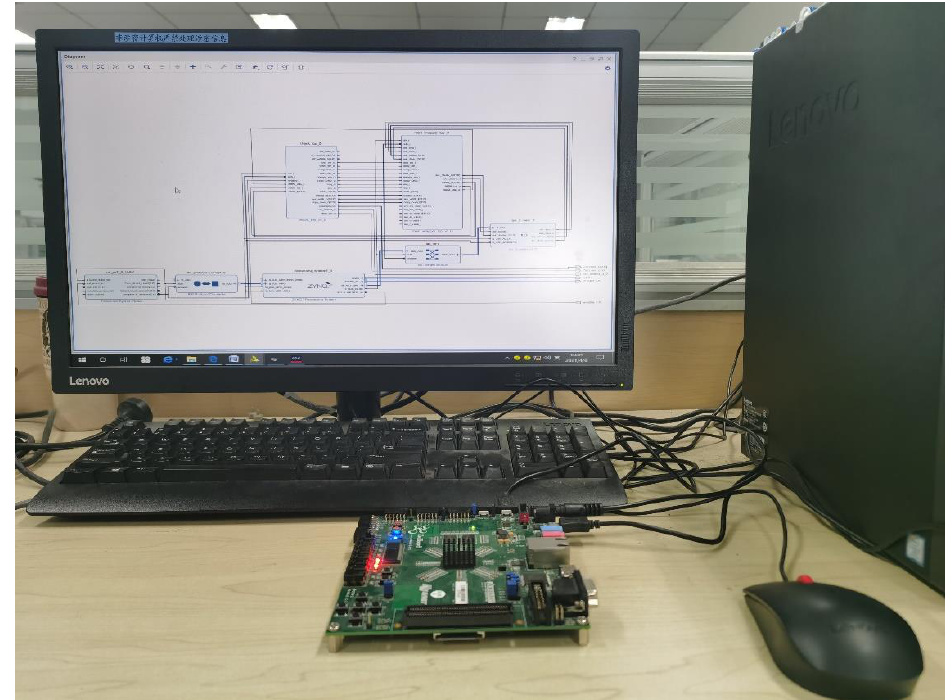
Figure 13. RDAMS performing detection.